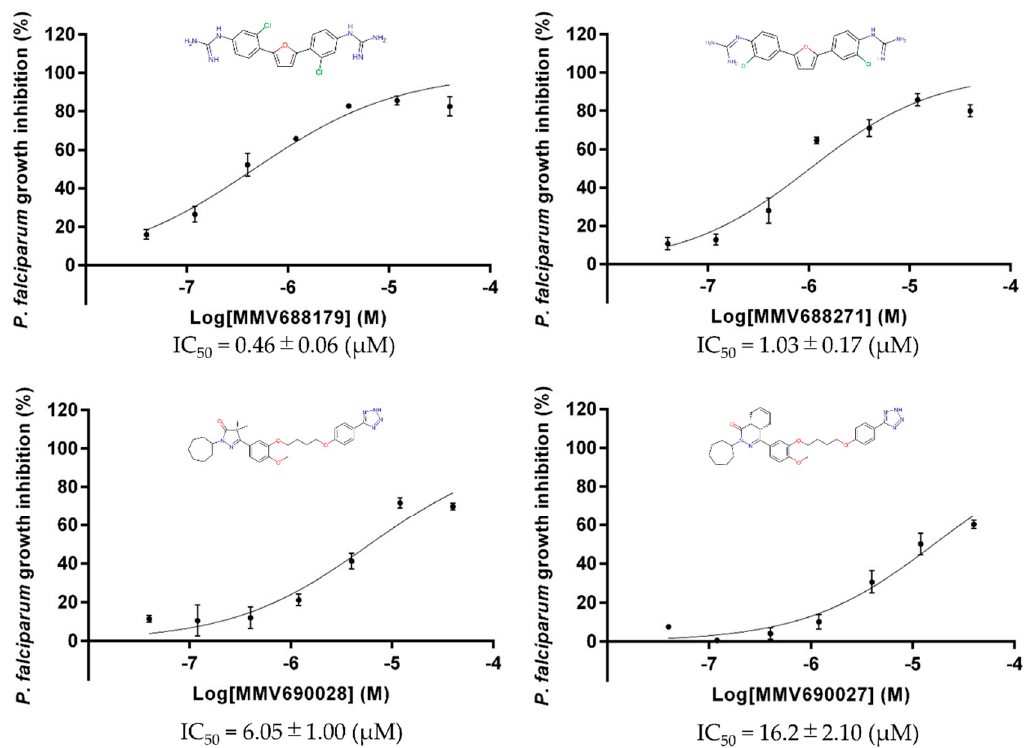
Figure 4. IC 50 of each strong hit compound from the Pathogen Box which showed inhibition against the asexual blood stage (ABS) parasite.